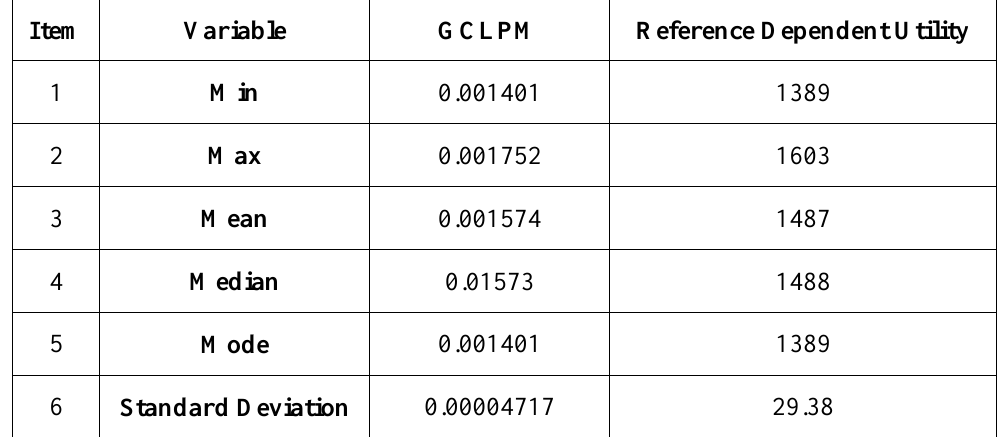
Table 4. Result Specification of Scenario 1 in Second